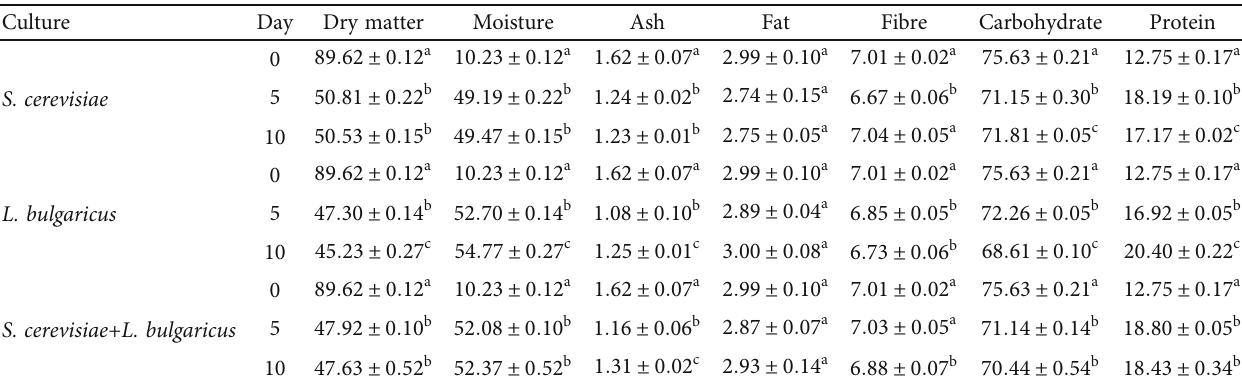
Table 6: Changes in the chemical composition of fermented, formulated blends of unmalted and malted sorghum in a ratio of 3 :1 ( w / w ) with monocultures of S . cerevisiae or L . bulgaricus and a coculture of S . cerevisiae and L . bulgaricus (data presented are based on the dry matter). a – c Means within a column with di ff erent superscripts are signi fi cantly di ff erent ( p ≤ 0 : 05 ). Results expressed as mean ð n = 3 Þ ± SD (standard